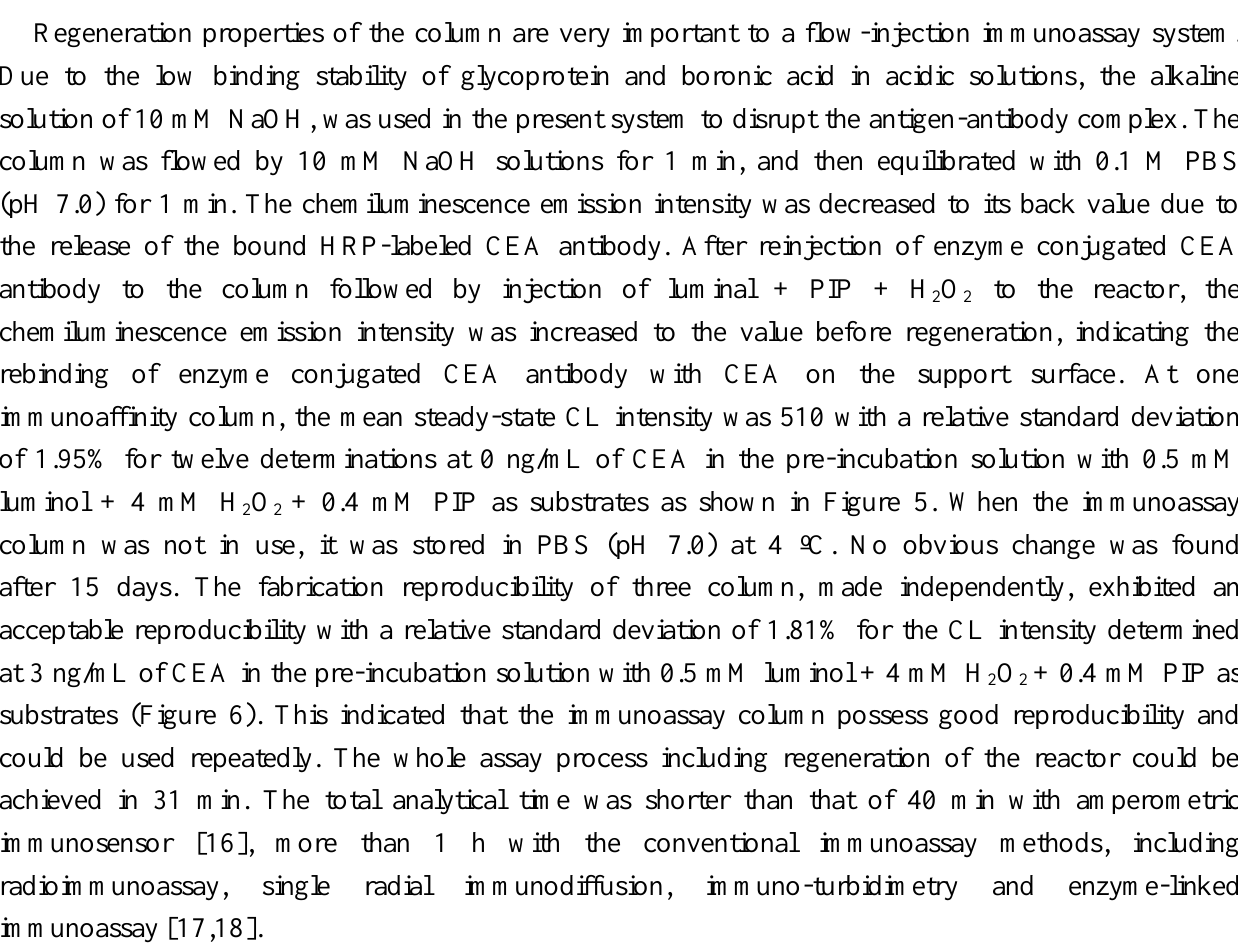
O + 0.4 mM PIP at CEA 2 2